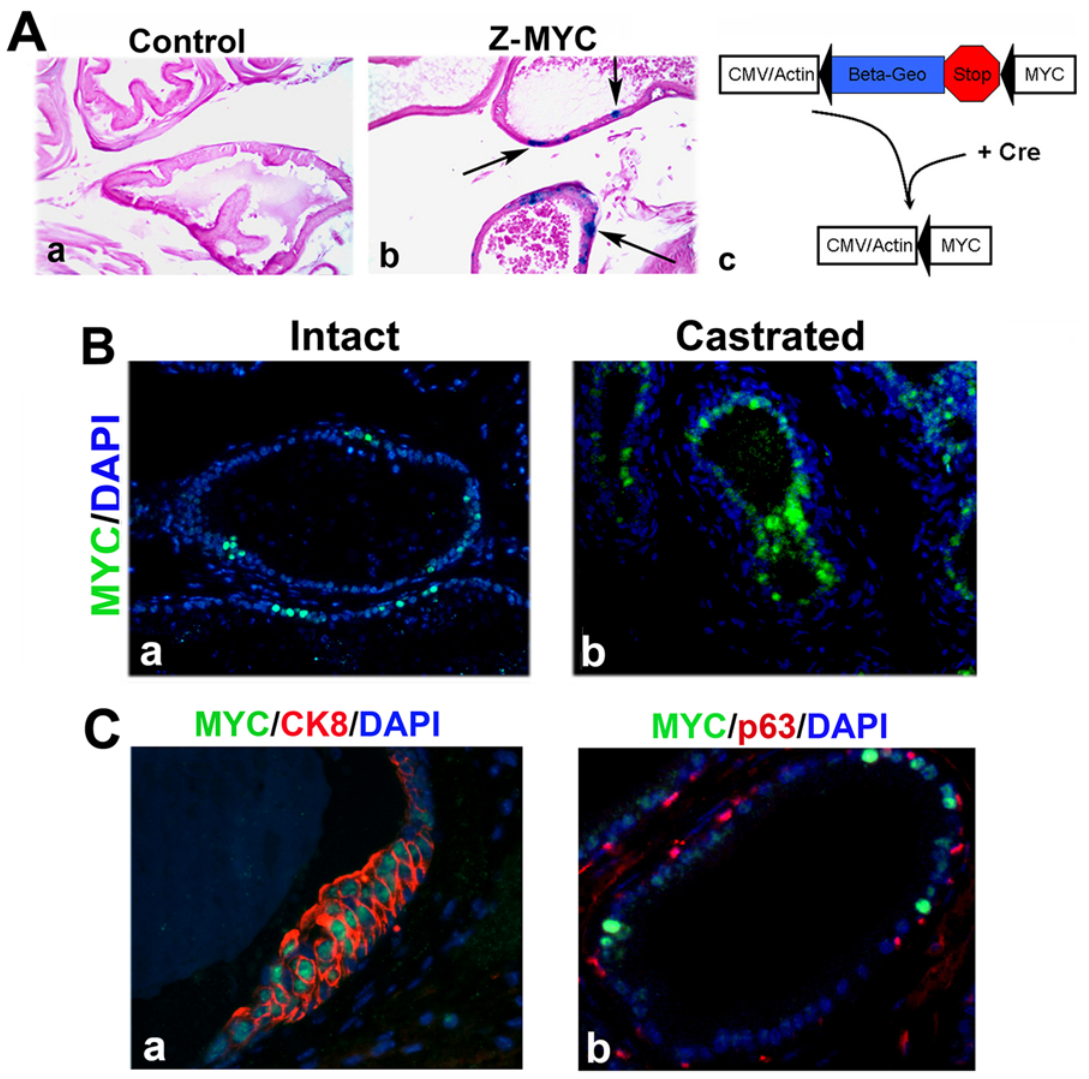
Figure 1. c-MYC expression in PbCre4;Z-MYC mouse prostate is mosaic and uncoupled from androgen regulation. (A) LacZ stain depicts mosaic expression of transgene in Z-MYC prostate. Arrows indicate LacZ-positive cells. The frequency of transgene-expressing cells varied depending on glands and lobes, but quantitative analysis indicated that overall, LacZ-positive cells comprised , 17% of the epithelial cells in any LacZ-positive gland (a) and (b). (c) shows schematic representation of Cre excision of the Z-MYC construct. c-MYC expression is activated and regulated by CMV/ Actin promoter after Cre-excision. (B) Immunostaining verifies sporadic c-MYC expression in PbCre4;Z-MYC prostate epithelium of intact mouse (a) and 17 weeks after castration (b). (C) c-MYC colocalizes with cytokeratin 8 (CK8) (a) but not with p63 (b) in PbCre4;Z-MYC mouse